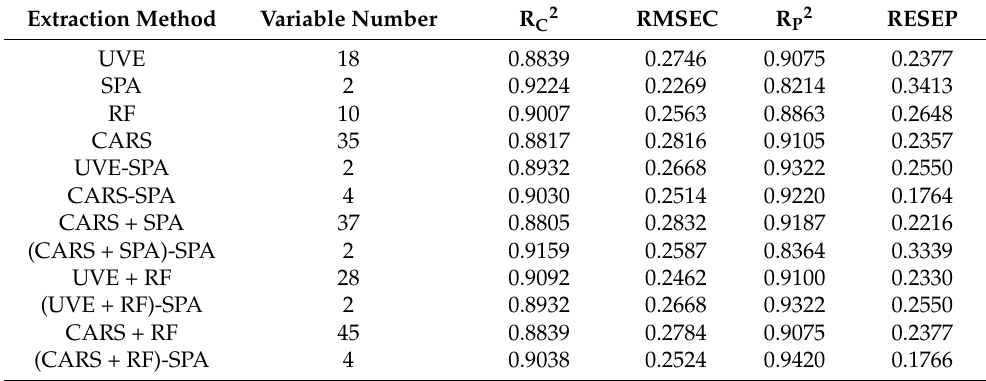
Table 5. Prediction results of SVR model established by different feature extraction